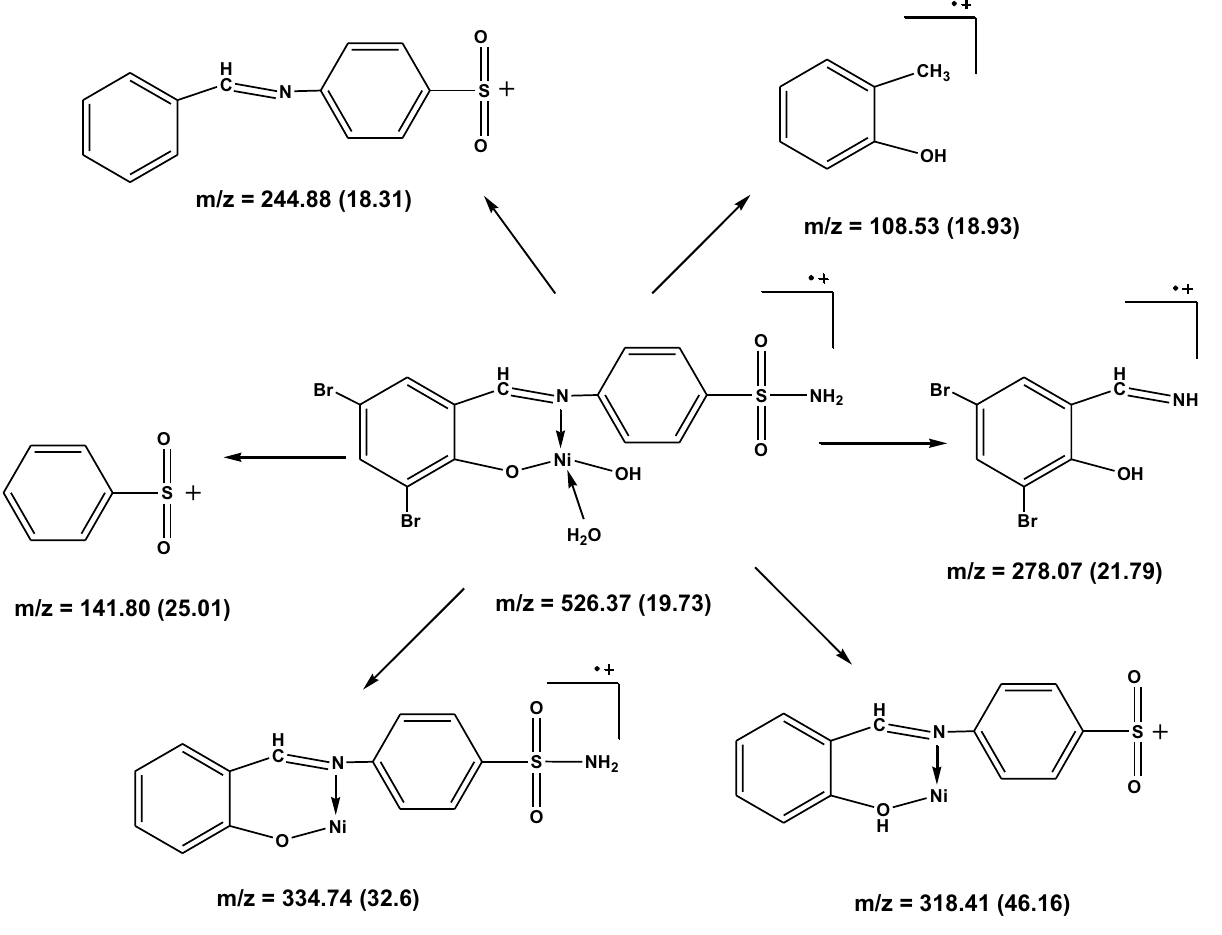
Figure 8. Proposed mass fragmentation of [Ni(SB 3 –H)(OH)(H 2 O)] complex.